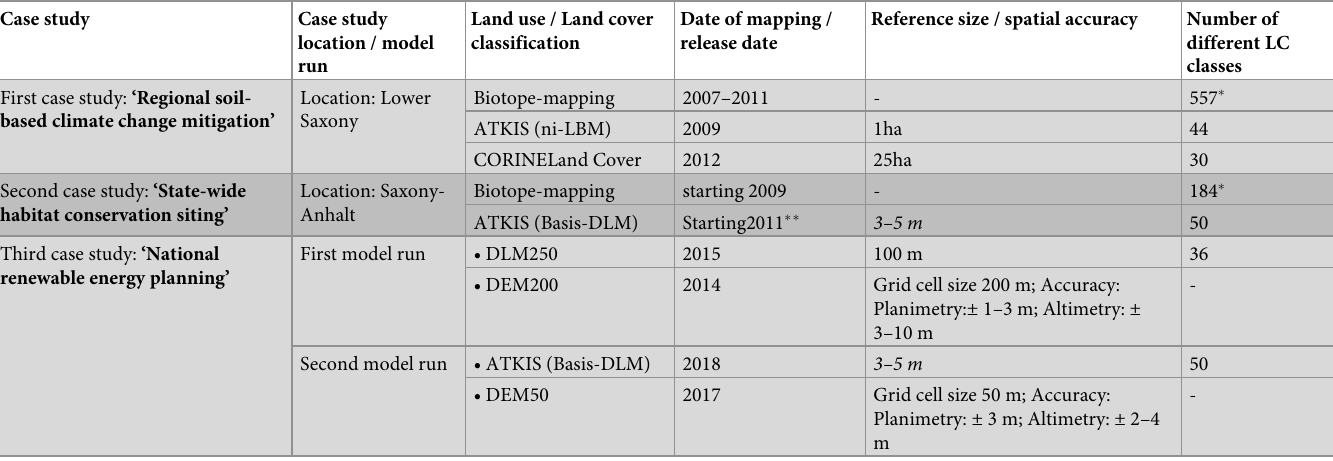
Table 1. Data applied in the case